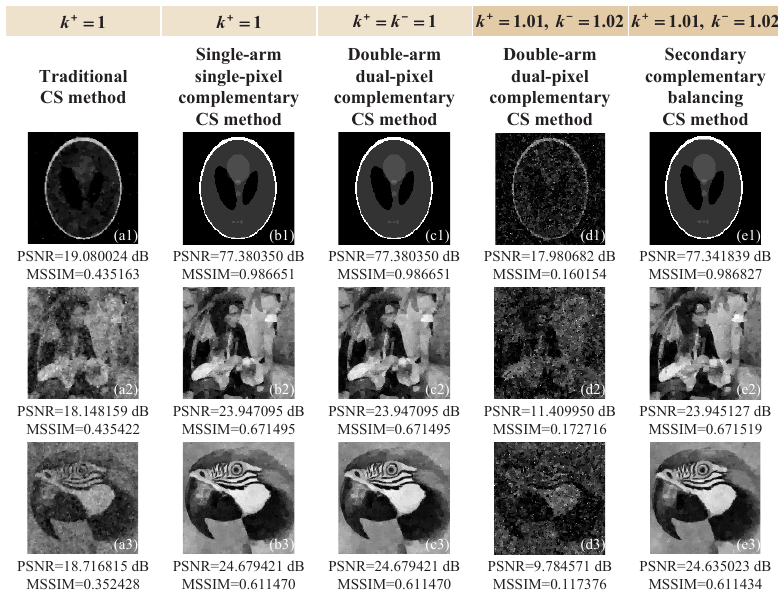
Figure 1. Simulation results of the traditional CS method without complementary measurements ( a1 – a3 ), the single-arm single-pixel complementary CS method ( b1 – b3 ), the double-arm dual-pixel complementary CS method in both an ideal situation ( c1 – c3 ) and imbalanced situation ( d1 – d3 ), and the secondary complementary balancing CS method in the imbalanced case ( e1 – e3 ), respectively. The pixel-sizes of reconstructed images are 128 × 128 and the total sampling ratios are all